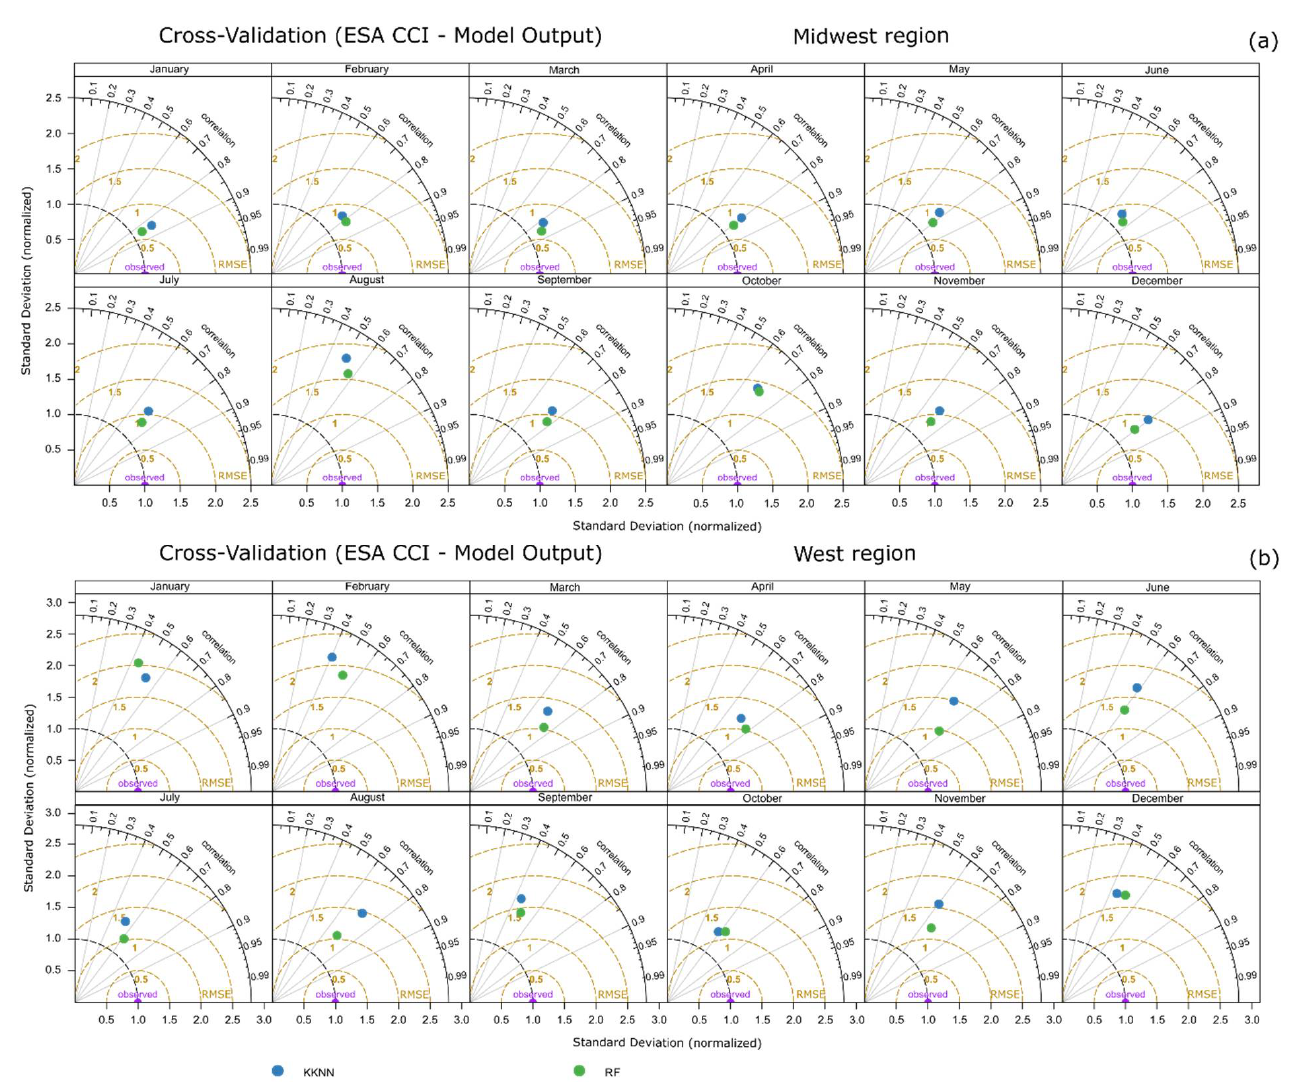
Figure 4. Taylor diagrams showing cross-validation between monthly 1 km predicted soil moisture and ESA-CCI reference data; ( a ) monthly cross-validation of the Midwest ROI; ( b ) monthly cross- validation of the West ROI.